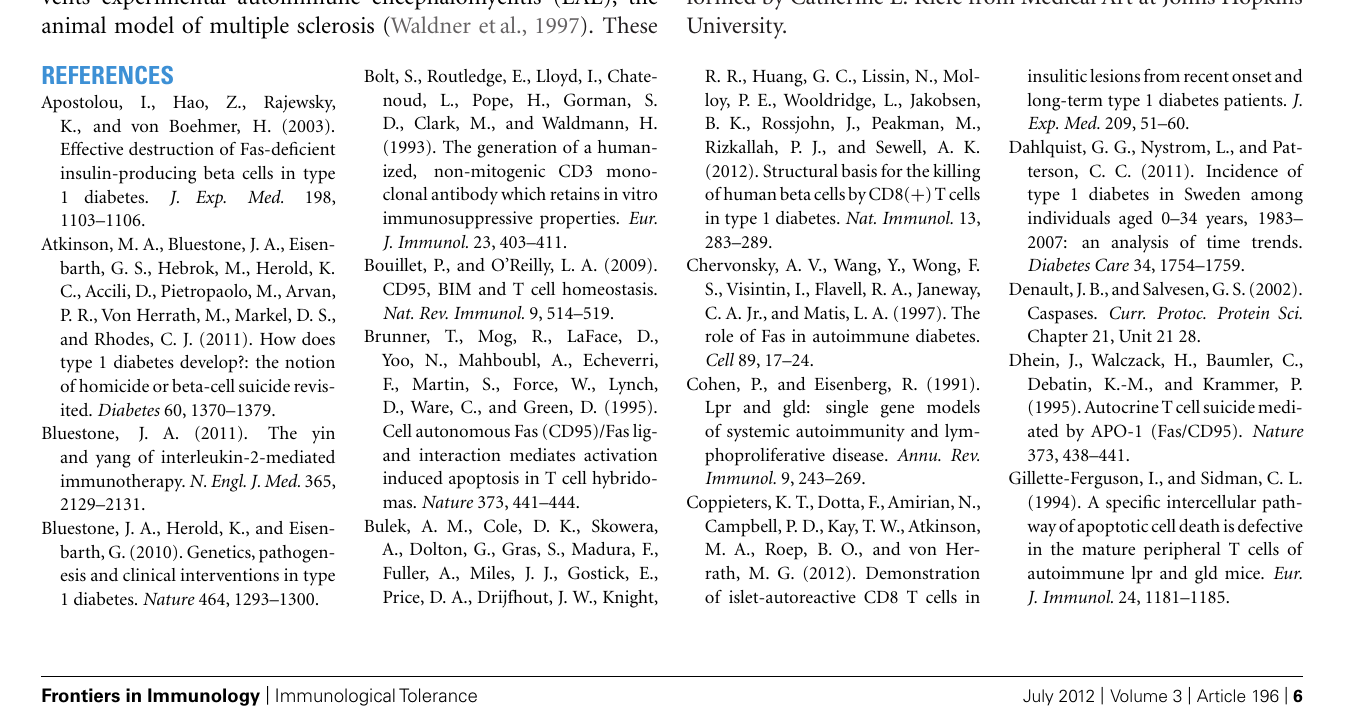
FasL: a counterintuitive immunotherapeutic